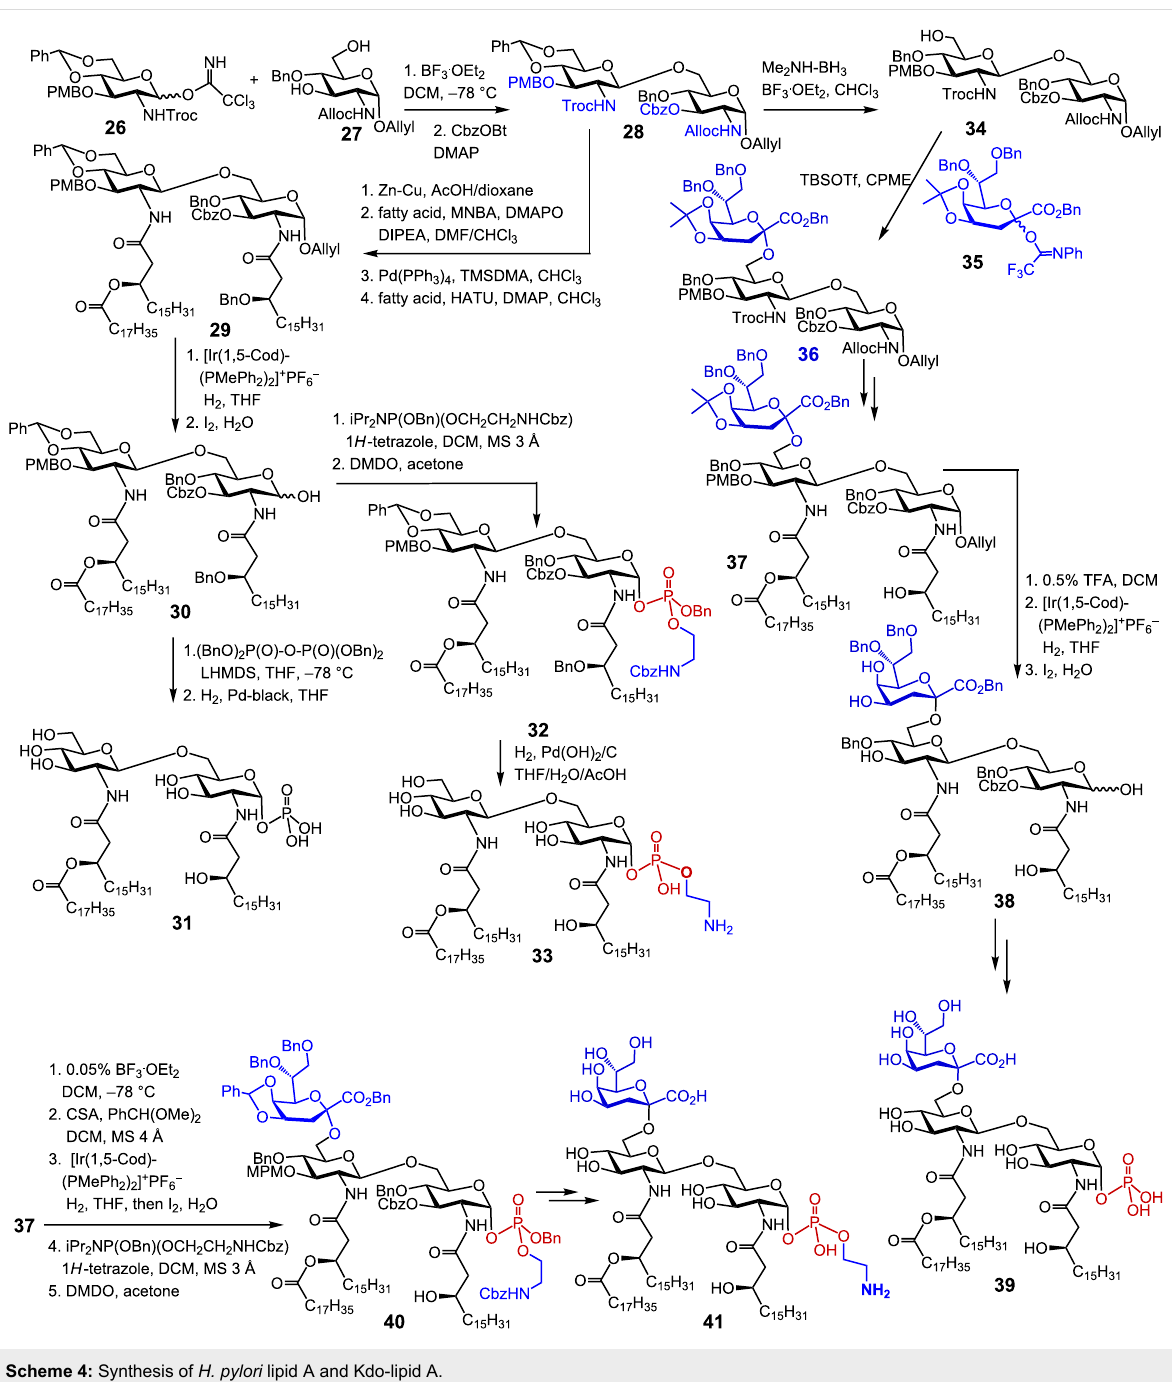
Scheme 4: Synthesis of H. pylori lipid A and Kdo-lipid